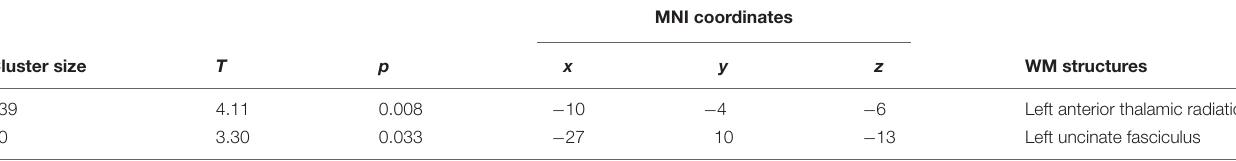
Refer to Table 2 for a detailed explanation of the table layout.